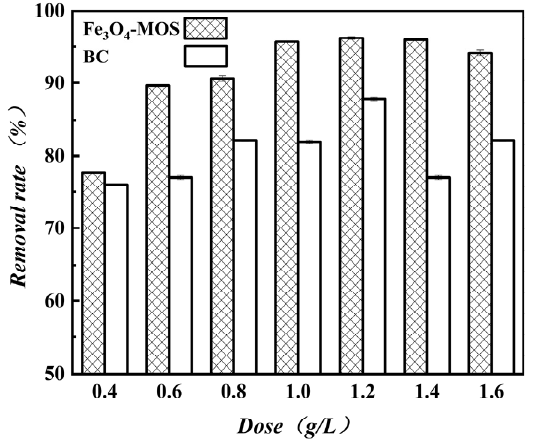
Figure 7. Dosage-dependent change in MB adsorption by BC and Fe 3 O 4